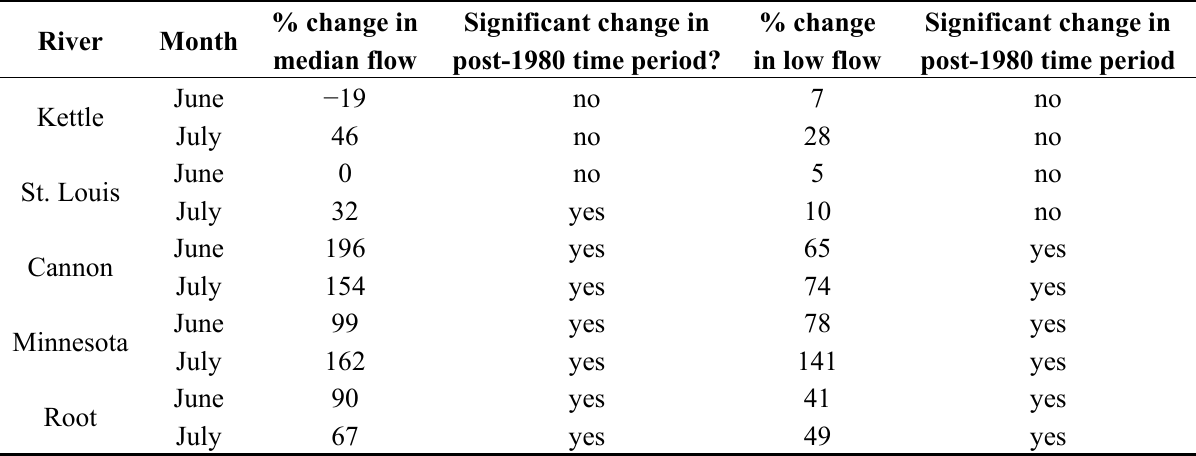
Table 3. Changes to June and July median and low flows at the five study rivers, comparing 1980 and 2009 to the entire previous period of flow record for each USGS gauge site. Significance was tested in the IHA program at the alpha = 0.05 level. Summer flow metrics were thought to be most related to turtle nesting